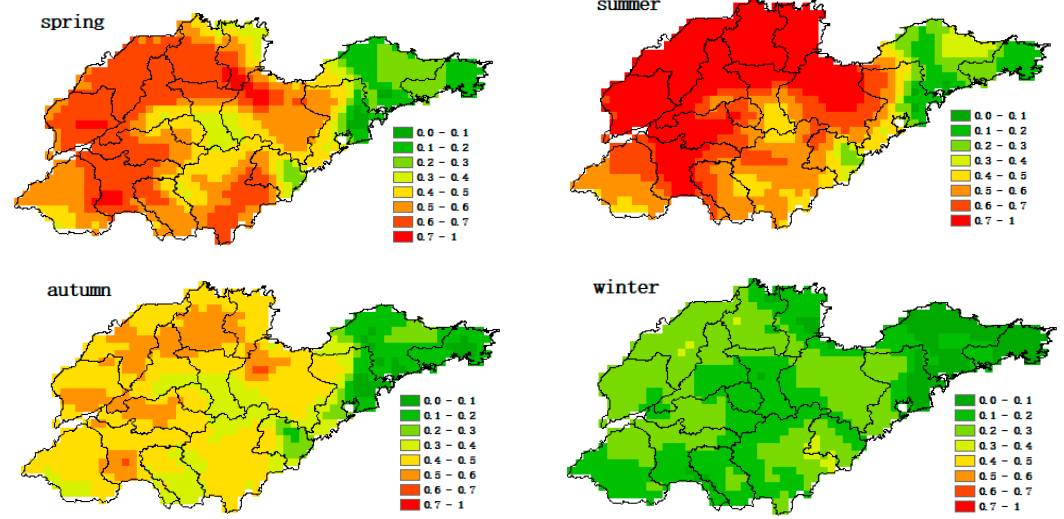
Figure 7. AOD quarterly distribution map.